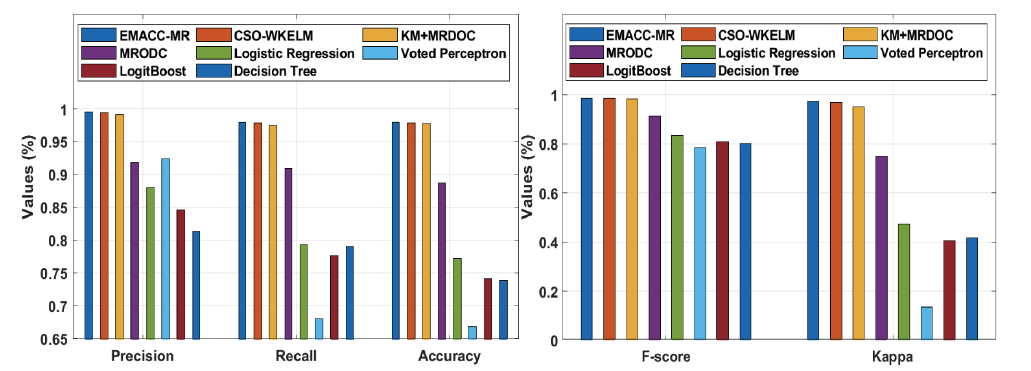
Fig. 4. (a) Result analysis of the EMACC-MR Method on the Pima Indian Diabetes Dataset with distinct classifier, (b) F-score and kappa analysis of the EMACC-MR Method on the Pima Indian Diabetes Dataset with distinct classifier